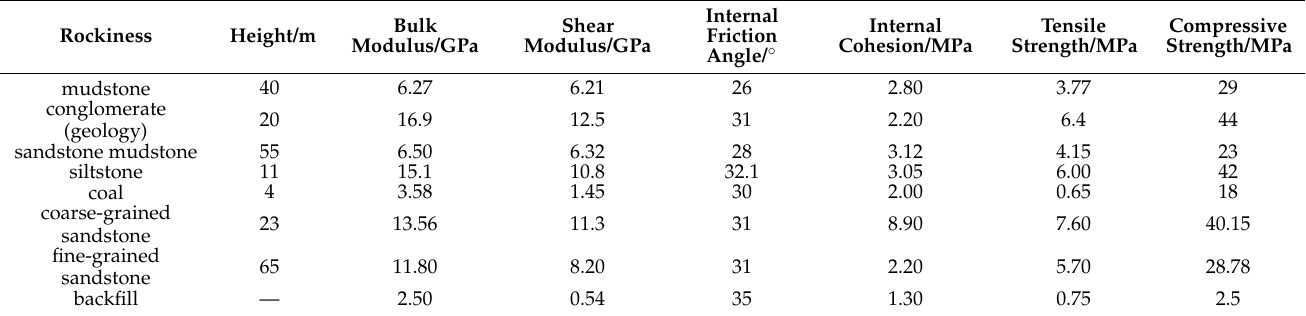
Table 1. Physical and mechanical parameters table of coal and rock